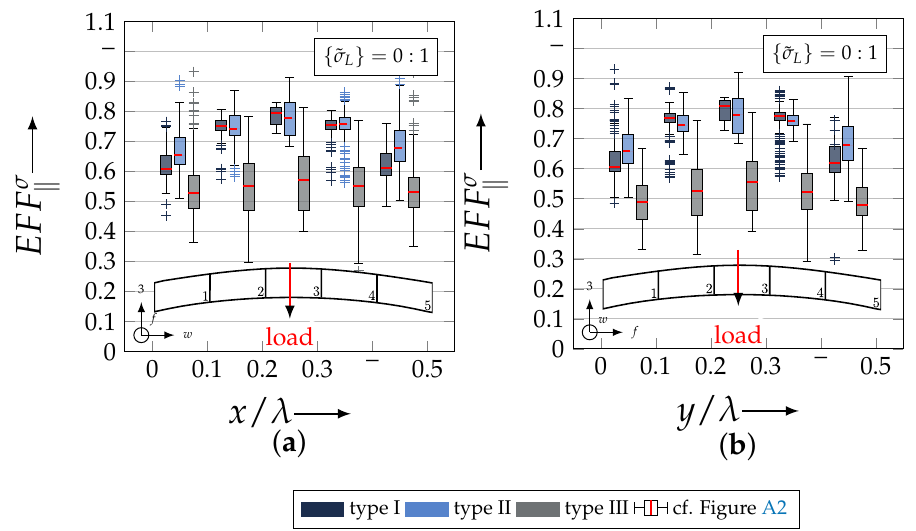
Figure 31. Illustration of stress effort EFF σ load ratio { ˜ σ L } = 0:1 for ( a ) weft and ( b ) fill